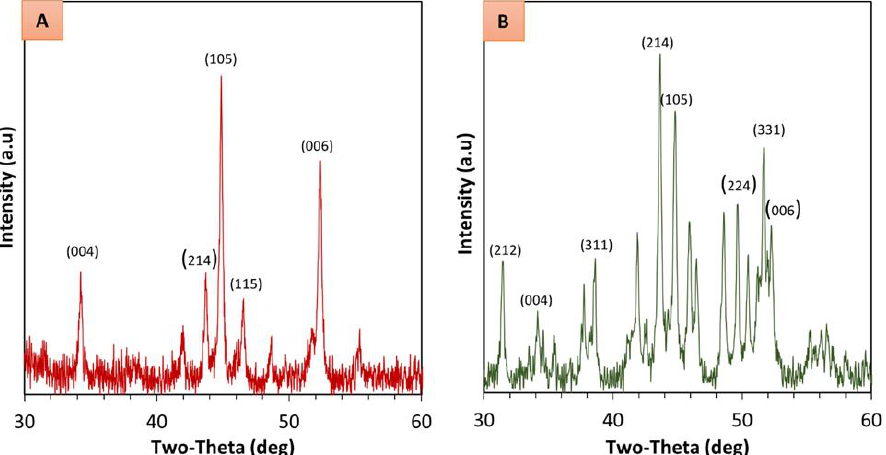
Figure 11. XRD patterns of ( A ) anisotropic magnetic composite fabricated with external magnetic field application, and ( B ) isotropic magnetic composite fabricated without an external magnetic field.